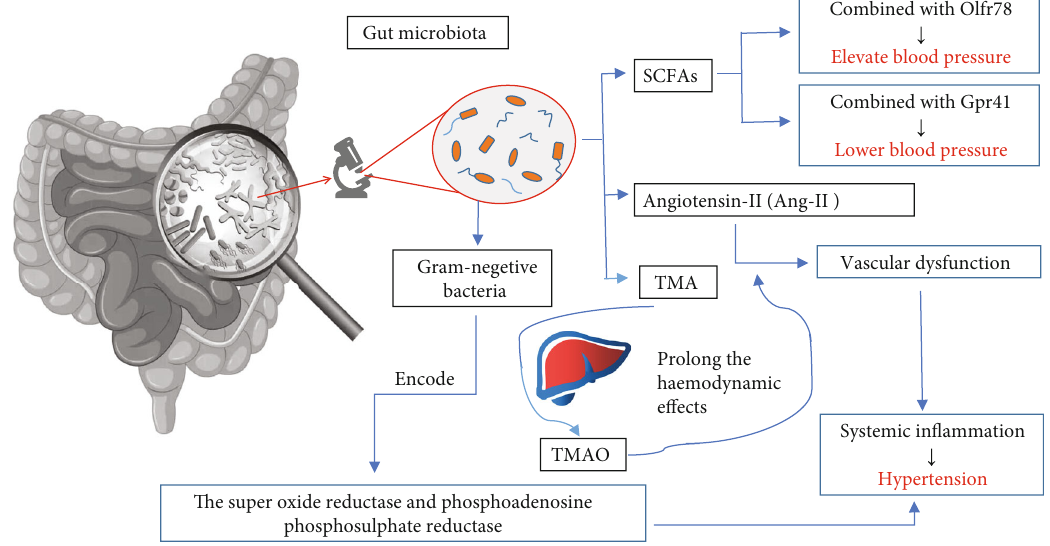
Figure 1: The e ff ect of GM on blood